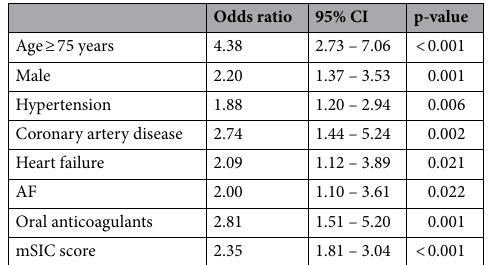
Table 2. Univariate logistic regression analysis of variables that were significantly different between survivors and non-survivors. AF Atrial Fibrillation, mSIC modified Sepsis-Induced Coagulopathy